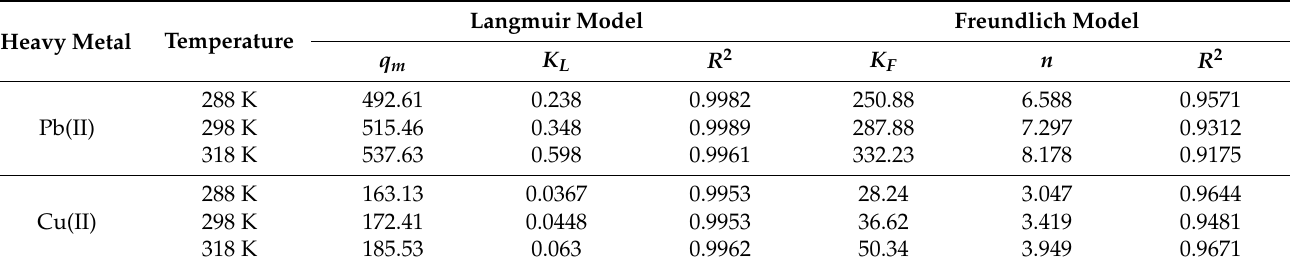
Table 9. The corresponding parameters of the adsorption isotherm fitting.